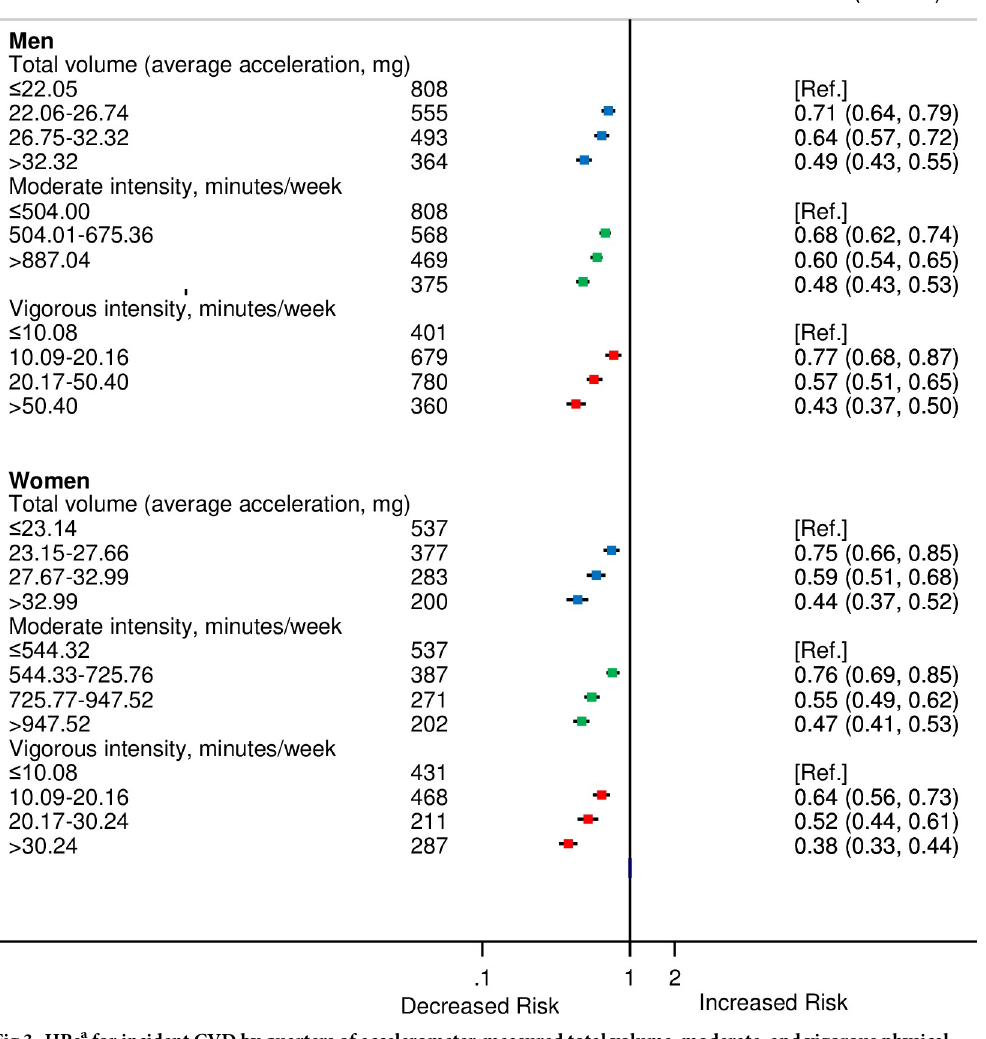
Fig 3. HRs a for incident CVD by quarters of accelerometer-measured total volume, moderate, and vigorous physical activities stratified by sex in 90,211 UK Biobank participants. a Adjusted for age (stratified by 5-year age-at-risk intervals), ethnicity, education, Townsend Deprivation Index, smoking, and alcohol